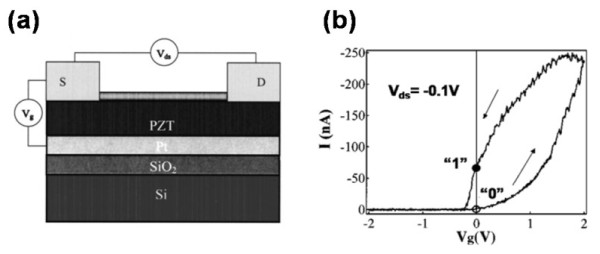
Schematic circuit diagram of In2O3nanowire FeFET (a) and characteristics of PZT-gated In2O3NW transistor (b). The PZT-gated In2O3 NW transistor with VDS = −0.1 V shows pronounced hysteresis. ‘1’ and ‘0’ denote two states at VG = 0 V for the memory operation.